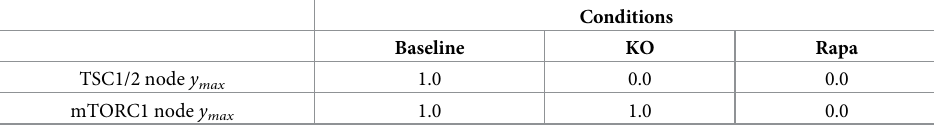
Table 2. Summary of the three primary simulated